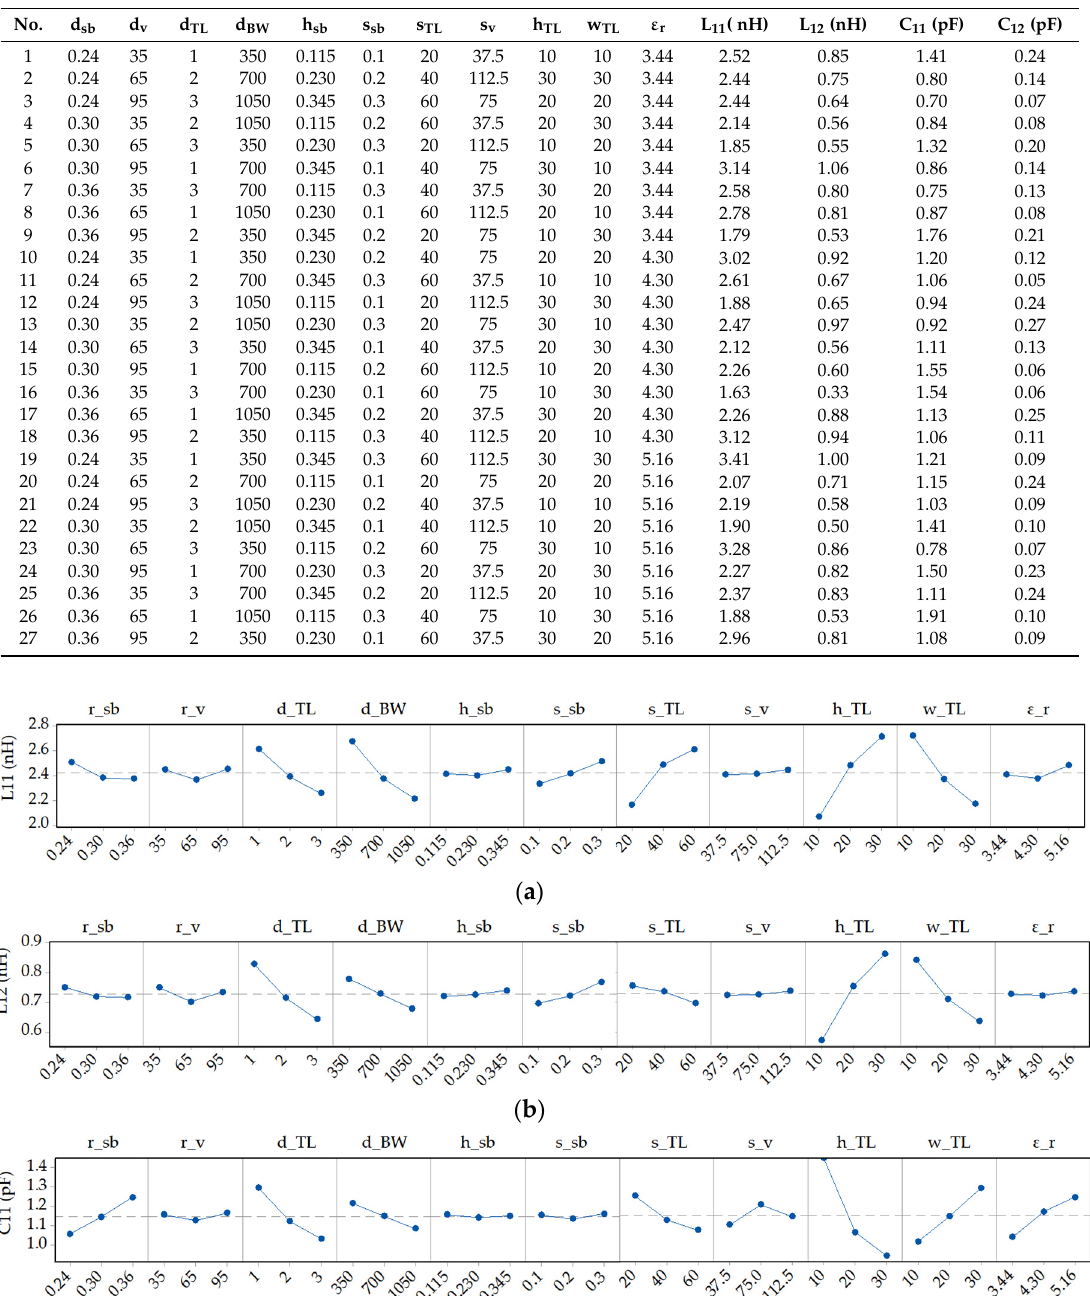
Table 2. Orthogonal array (OA) of the IC-package interconnect for the Taguchi analysis.